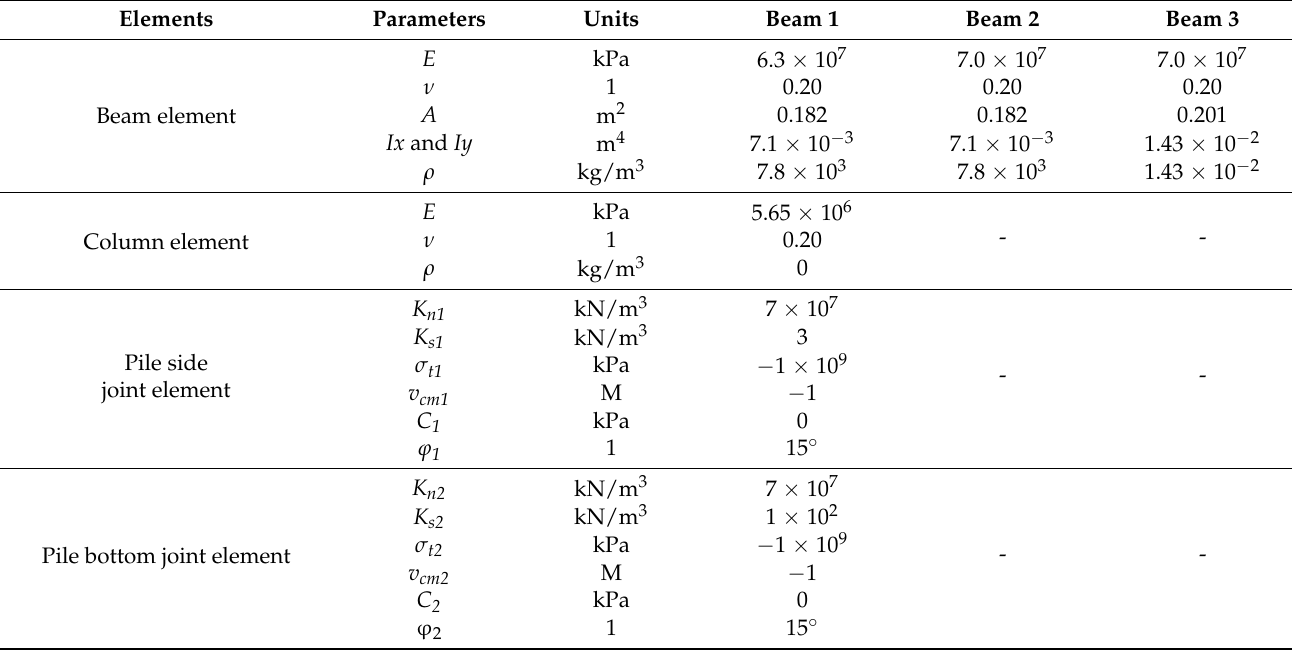
Table 5. Material parameters of pile used for calculation.